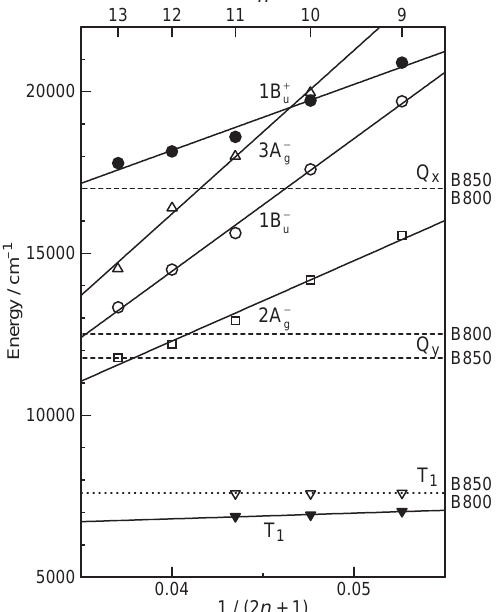
Figure 1. A diagram comparing the energies of the singlet- and triplet-excited states of Cars with those of BChl a . The energies of the optically-allowed 1B u+ state and the optically-forbidden 3A g– , 1B u– and 2A g– states were determined by measurement of resonance-Raman excitation profiles of crystalline mini- β -carotene, spheroidene, lycopene, anhydrorhodovibrin and spirilloxanthin ( n = 9~13) [1]. The T ( n = 9~11) and BChl a bound to LH2 antenna complexes were determined by high- sensitively emission spectroscopy [2] ([9]–reproduced by permission of The Royal Society of Chemistry).